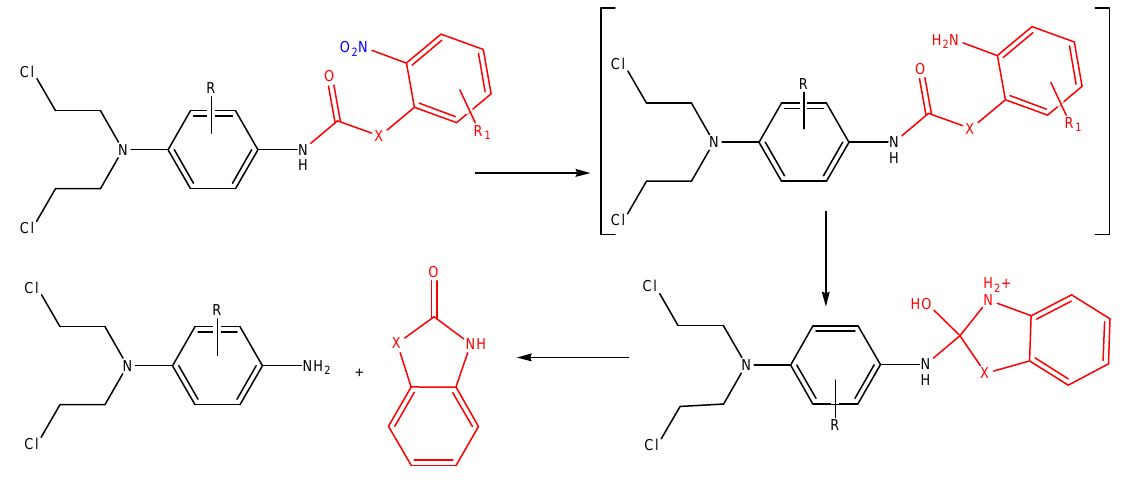
Scheme 5 . Mechanism of activation of 2-aminoaryl derivatives.